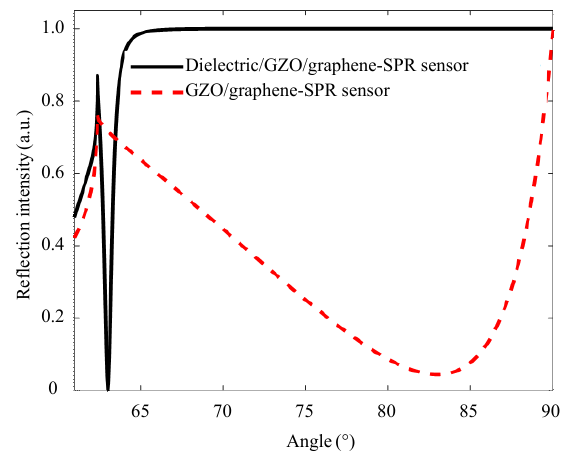
Fig. 3 Reflectance curve for the GZO/graphene SPR sensor with and without using dielectric (thicknesses used for graphene, dielectric, and GZO are 0.34 nm, 2 000 nm, and 20 nm, respectively; RIs for the dielectric medium and sensing medium are n d = 1.34 and n s = 1.33, respectively).